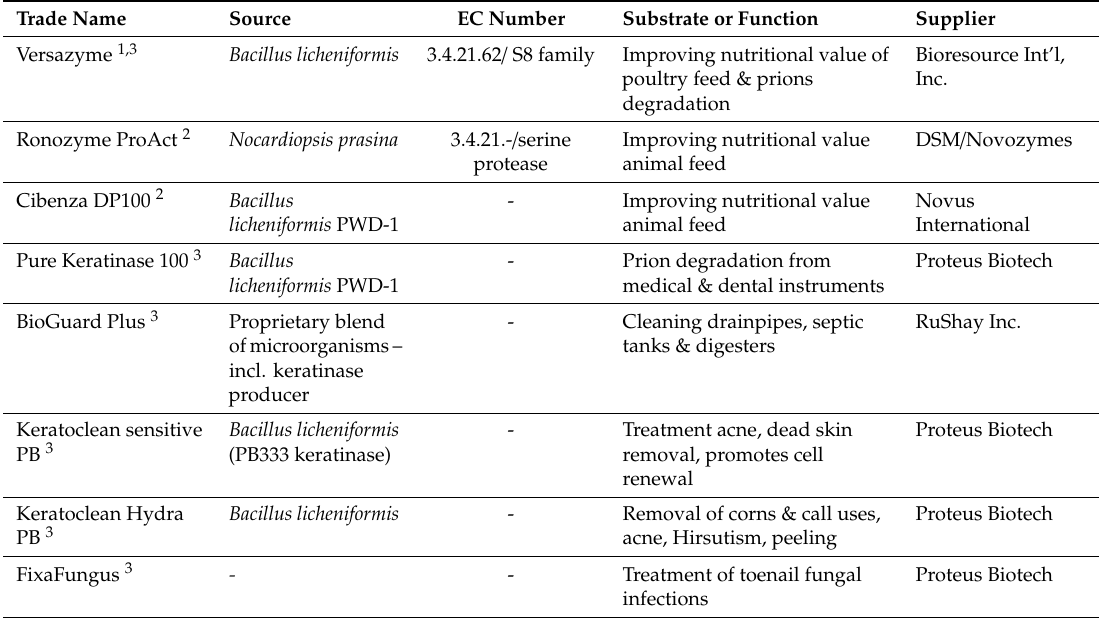
Table 7. Some examples of commercial